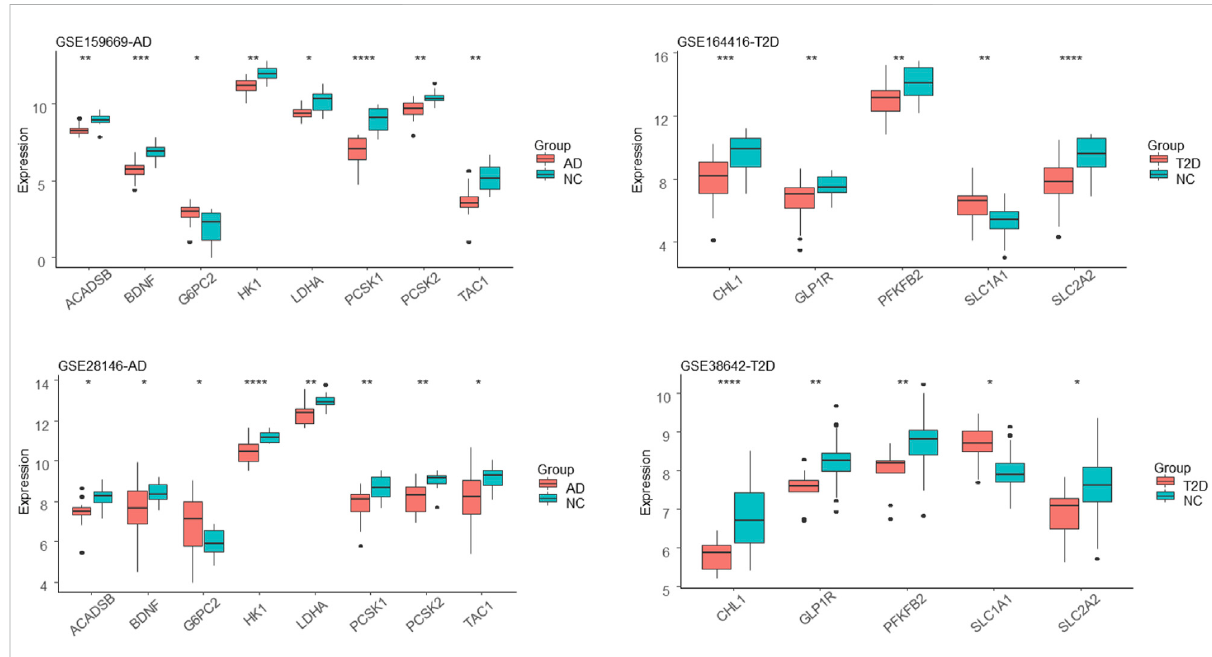
FIGURE 5 Expression distributionof the hub DEGs. AD and T2DMgroups are colored in pink and the corresponding control groups are coloredin cyan. *, **, ***, and **** represent the Mann-Whitney test p -value less than 0.05, 0.01, 0.001 and 0.0001,